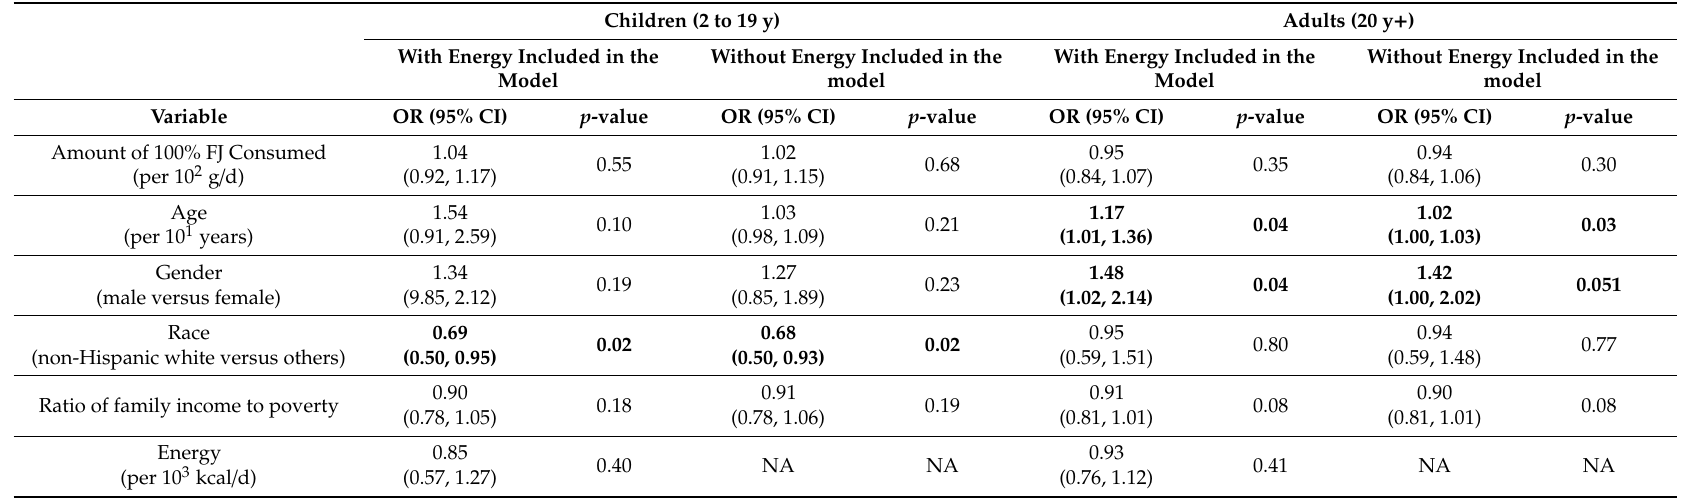
CI = confidence intervals; FJ = fruit juice; NA = not applicable; NHANES = National Health and Nutrition Examination Survey; OR = odds ratio; U.S. = United States; y = years; Bolded values were statistically